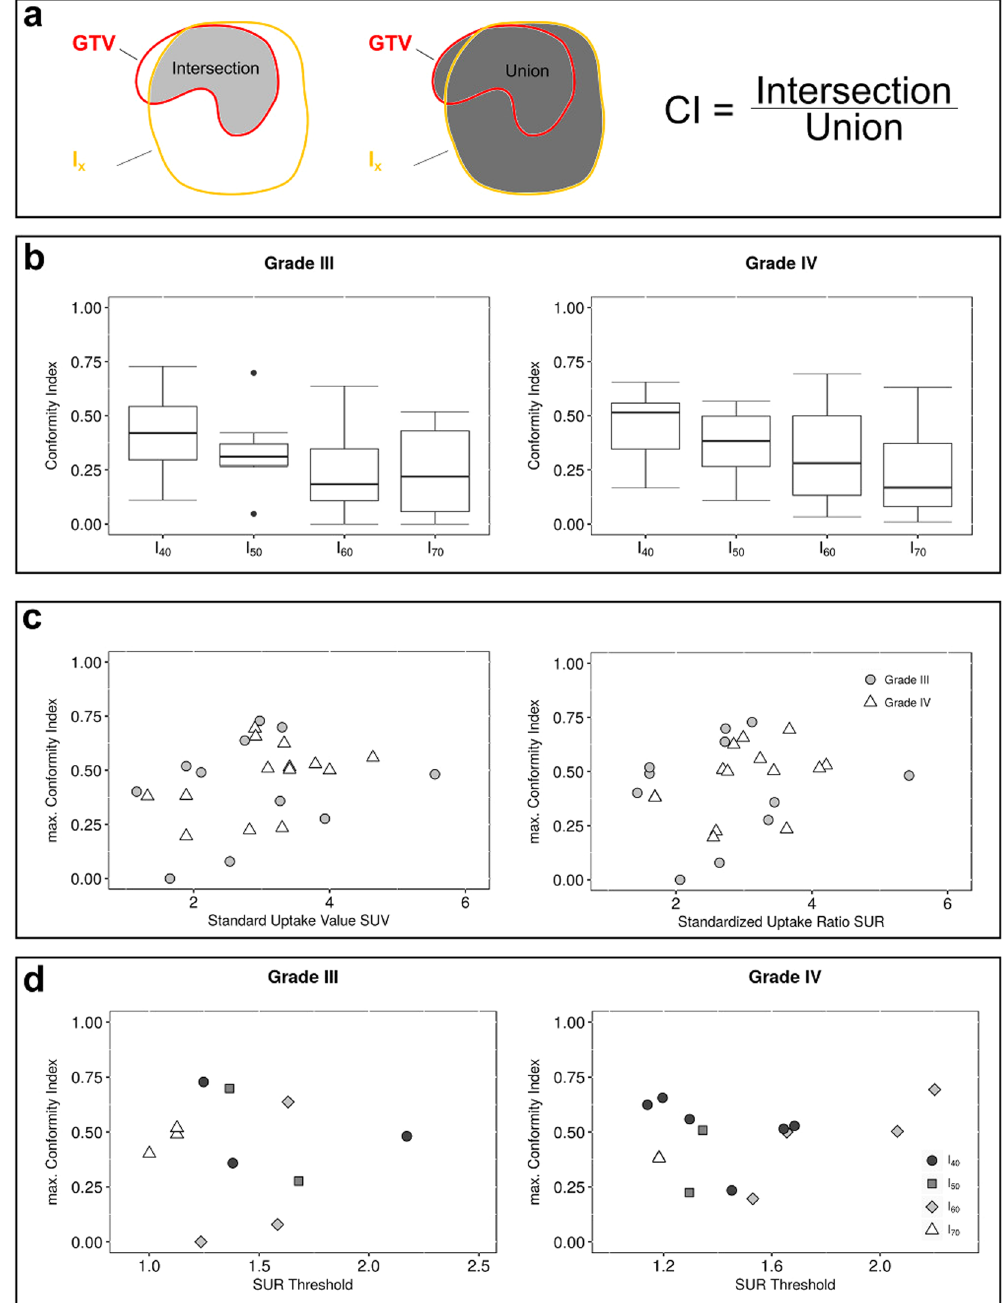
Figure 3. Quantification of overlap between different isocontour thresholds and MRI based GTV - the conformity index. The conformity index of each isocontour volume in a patient was calculated as intersection between isocontour and GTV normalized to their union, as schematically shown in ( a ). Boxplots in ( b ) show the distribution of conformity indices for every isocontour threshold. Higher thresholds (60%, 70%) yielded lower conformity, especially in grade IV glioma. The best matching isocontour was defined at the threshold yielding the highest conformity index with GTV. The corresponding highest conformity index is denoted as CI max . CI max showed a non-significant trend towards correlation with SUV and SUR ( c ), especially in grade IV tumors, indicating that higher uptake tends to yield better conformity. Applying the best matching isocontour percentage threshold to the SUR of a patient yielded a corresponding SUR cutoff that the best matching isocontour would correspond to. For all given isocontour thresholds these cutoffs were distributed over a broad range of SUR values ( d ), and did not cluster into individual